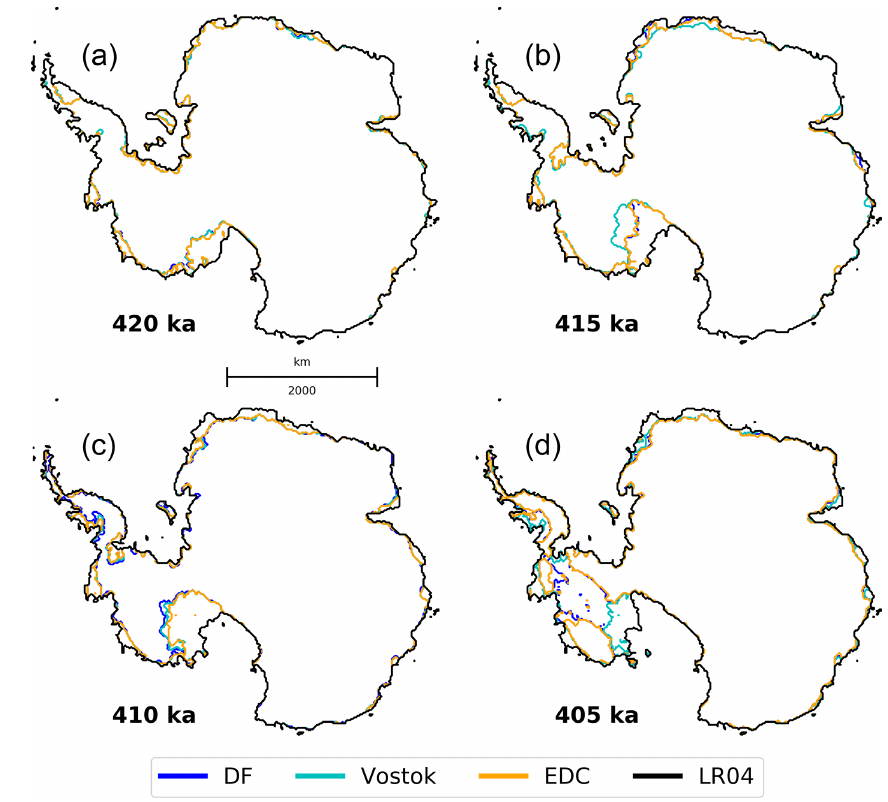
Figure 5. Grounding lines at 420, 415, 410, and 405ka for the CFEN simulations.